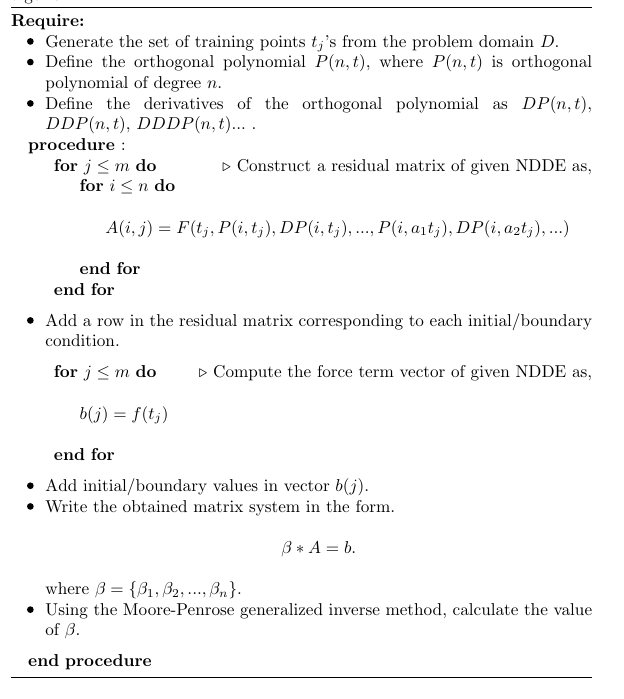
Algorithm 1 Pseudocode for solution of NDDE using ONN and ELM